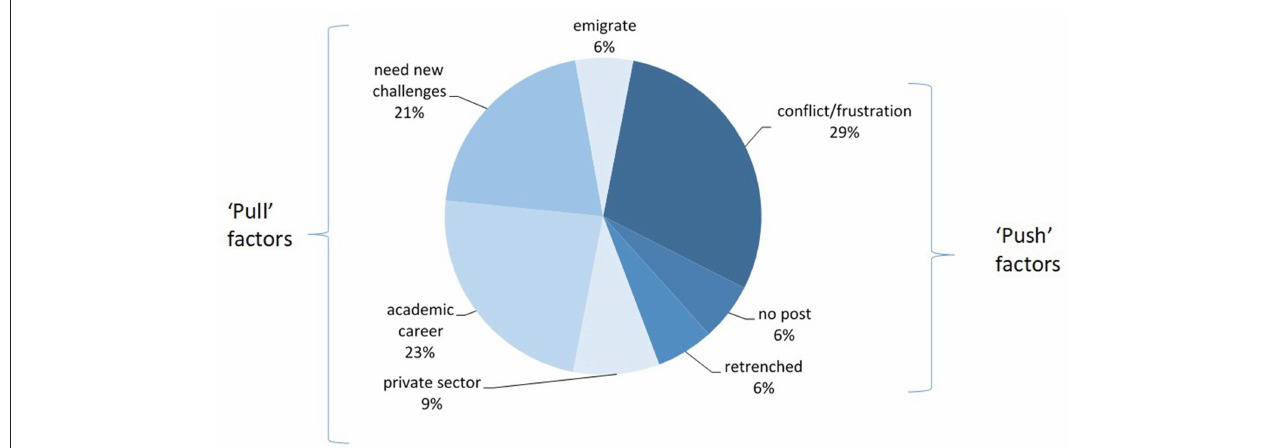
FIGURE 6 | Reasons for state-employed specialists leaving the state health sector ( n =